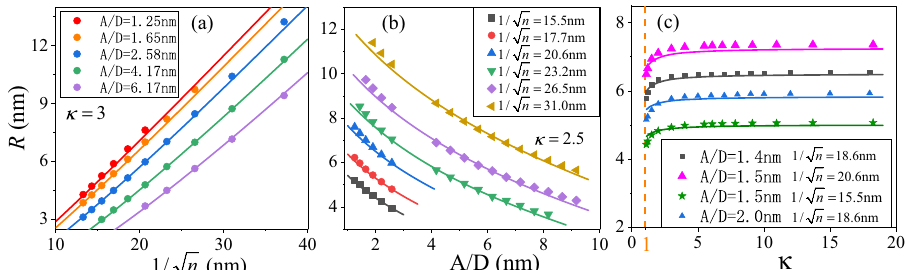
Fig. 4 Parameter dependences of skyrmion size. Skyrmion size in skyrmion crystals as a function of skyrmion number density n for various A / D and fi xed κ ( a ); as a function of A / D for various fi xed n and κ ( b ), and as a function of κ for various n and A / D ( c ). A is exchange stiffness constant, D is the Dzyaloshinskii – Moriya interaction coef fi cient D , and κ ≡ π 2 D 2 /(16 AK ), where K is the effective perpendicular magnetic anisotropy. The symbols are numerical data from MuMax3 simulations. The solid curves are the formula of Eq. (3).